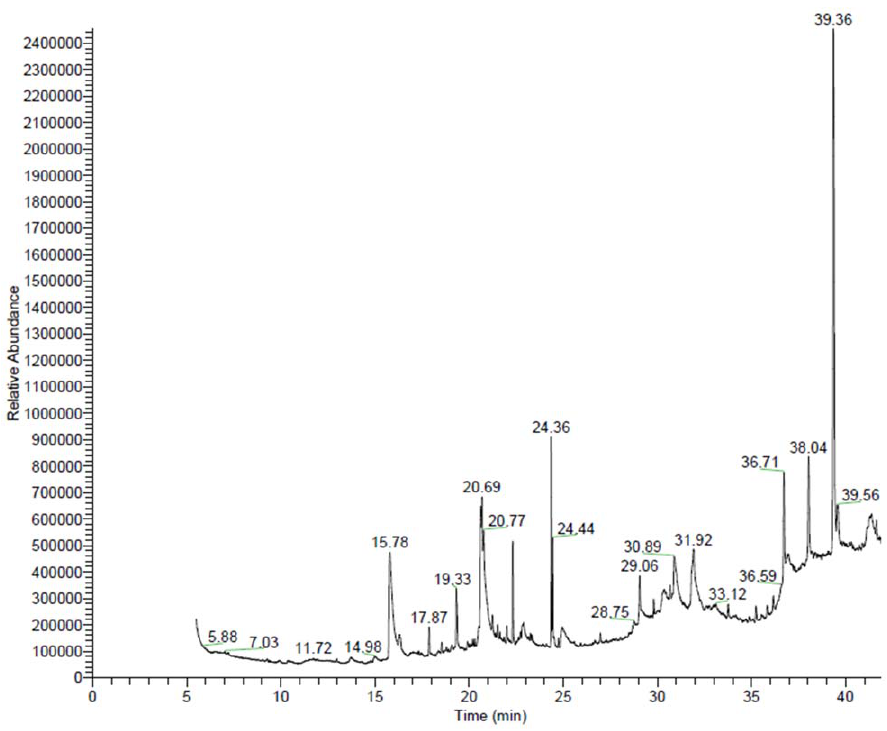
Figure 5. GC/MS chromatogram of methanol root extract of R.imbricata .